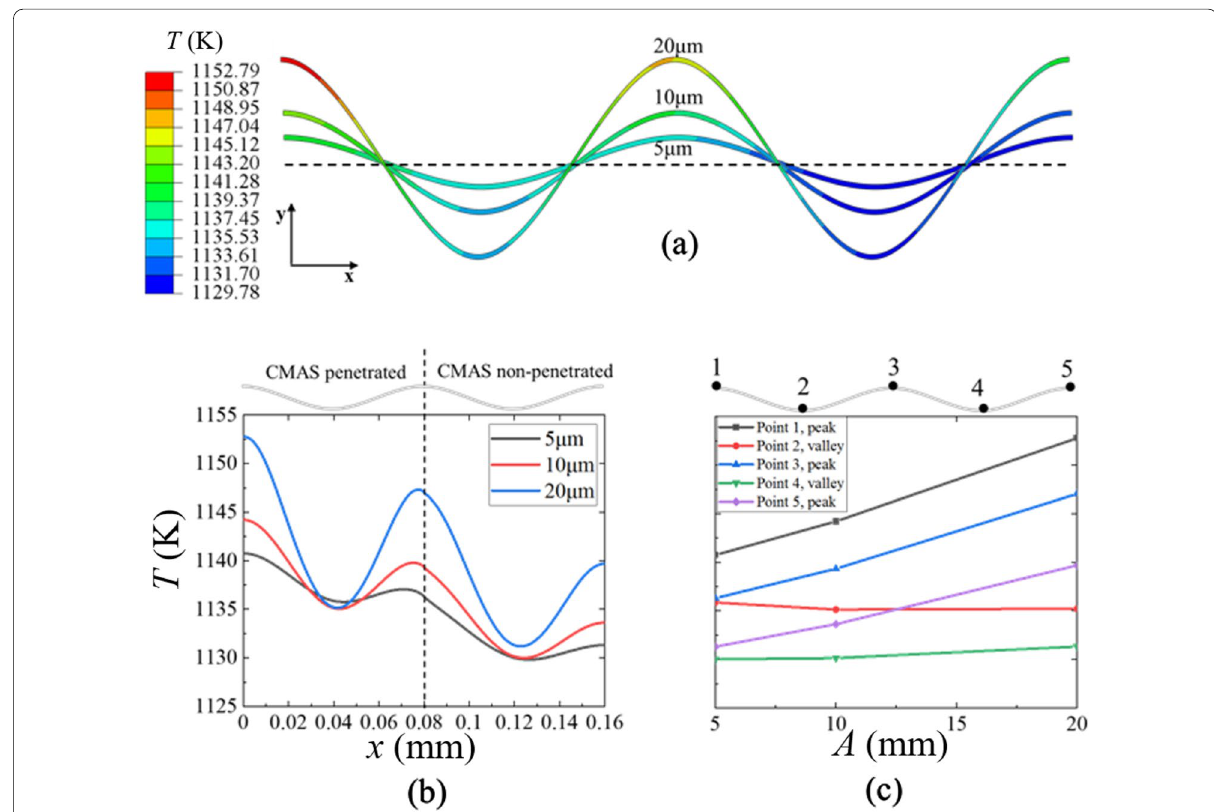
5, 10, and 20 μm), ( b ) interface temperature =